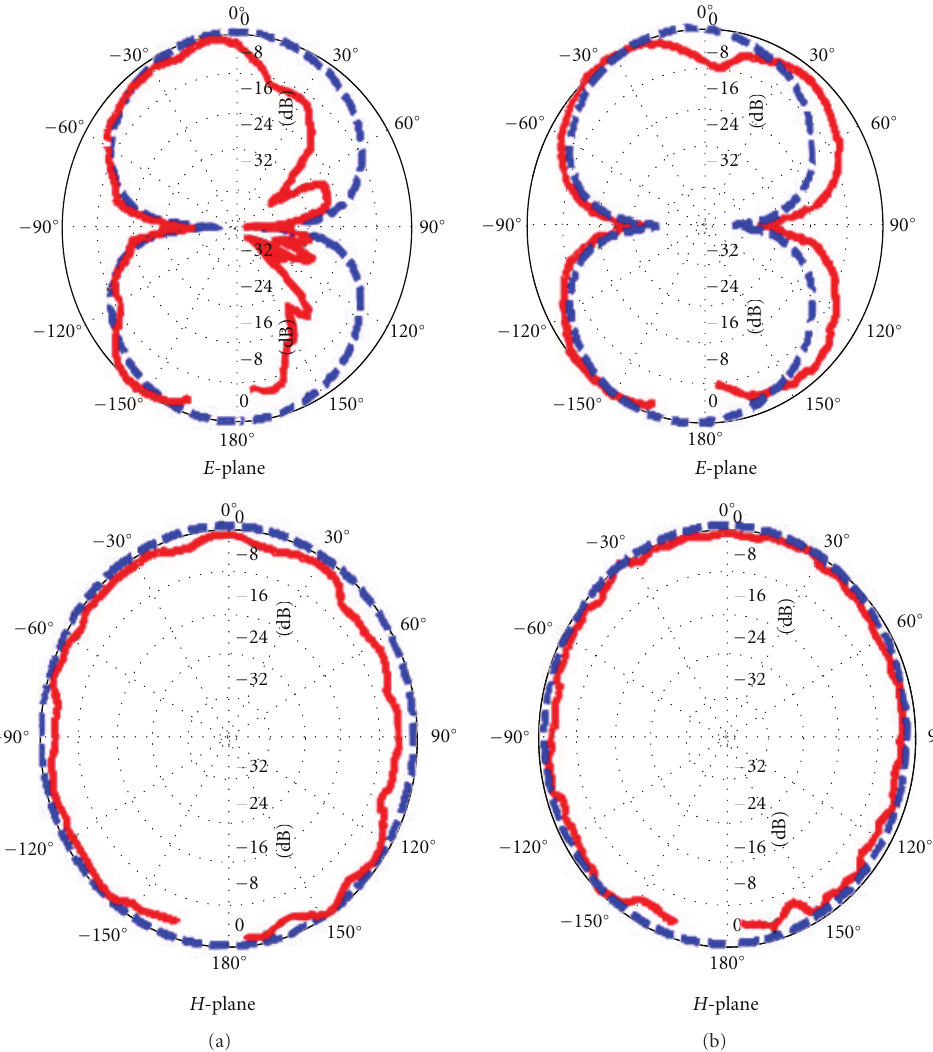
Figure 8: Simulated (dashed blue line) and measured (solid red line) normalised E -plane ( X-Y ) and H -plane ( X-Z ) radiation patterns, when antenna is in the UWB mode: (a) 3.4 GHz and (b) 5GHz. the notch frequency in UWB notched case or at out-of-band frequencies in the reconfigured bands I and